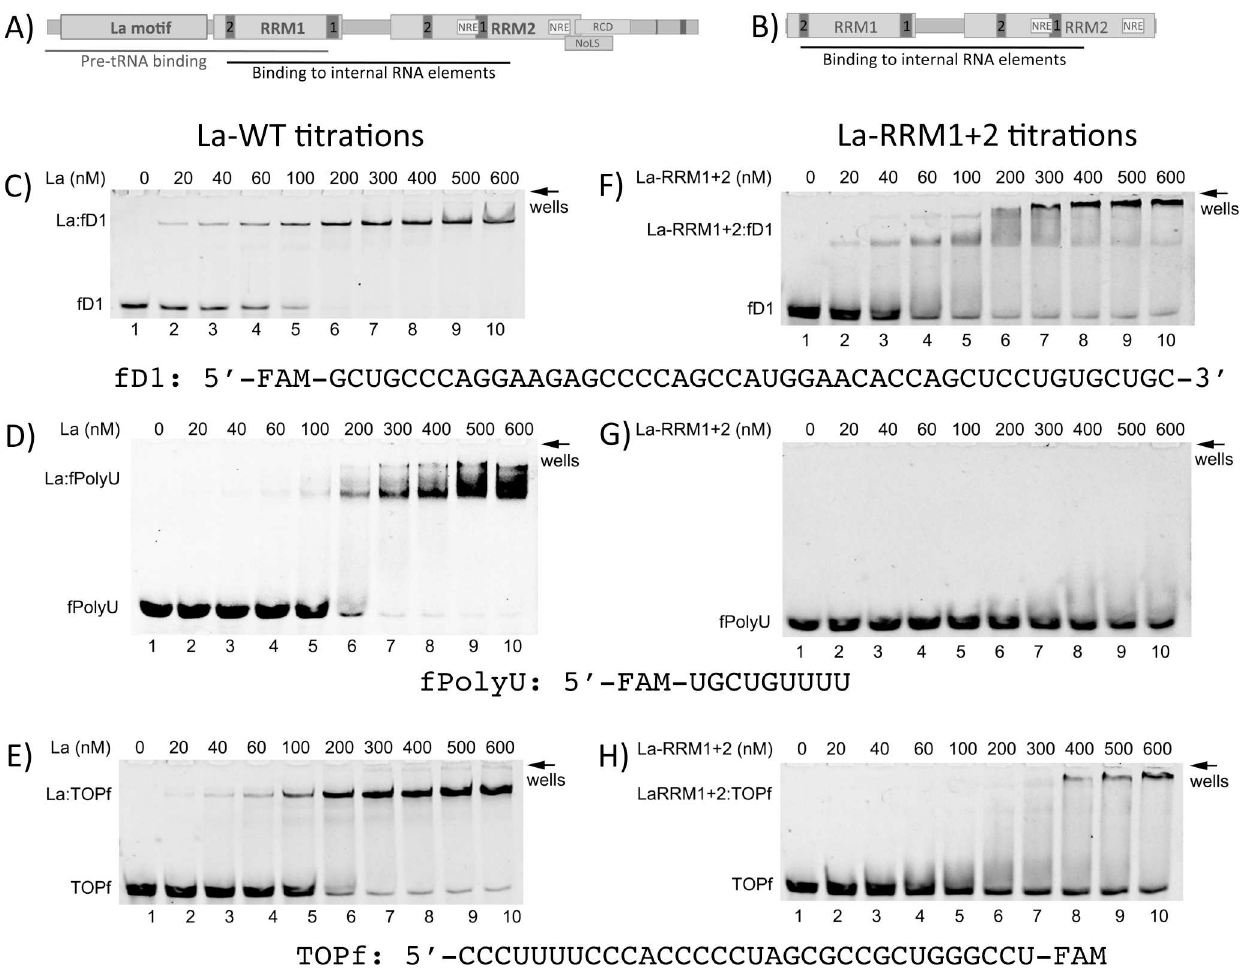
Fig 2. Binding of La wilstype and the minimal RNA-binding competent La-RRM1+2 mutant to different RNA substrates. Domain structure of La wildtype(La-WT) (A) and La-RRM1+2 mutant (B). Either recombinant La-WT or La-RRM1+2 protein was titrated into binding reactionscontaining50 nM fluorescence labeledfD1-RNA (C, F) , fPolyU-RNA (D, G) , or TOPf-RNA oligoribonucleotides (E, H) . The EMSA reactionswere loadedwithout dye and separatedon 10% native polyacrylamide gels. Representative gels of independent experiments are shown. All experiments were performed at least three